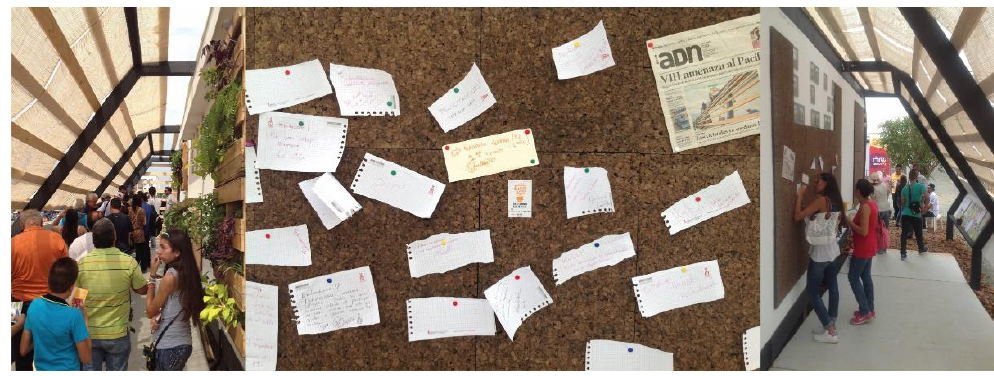
Figure 4. Survey integrated into the exhibition tour.